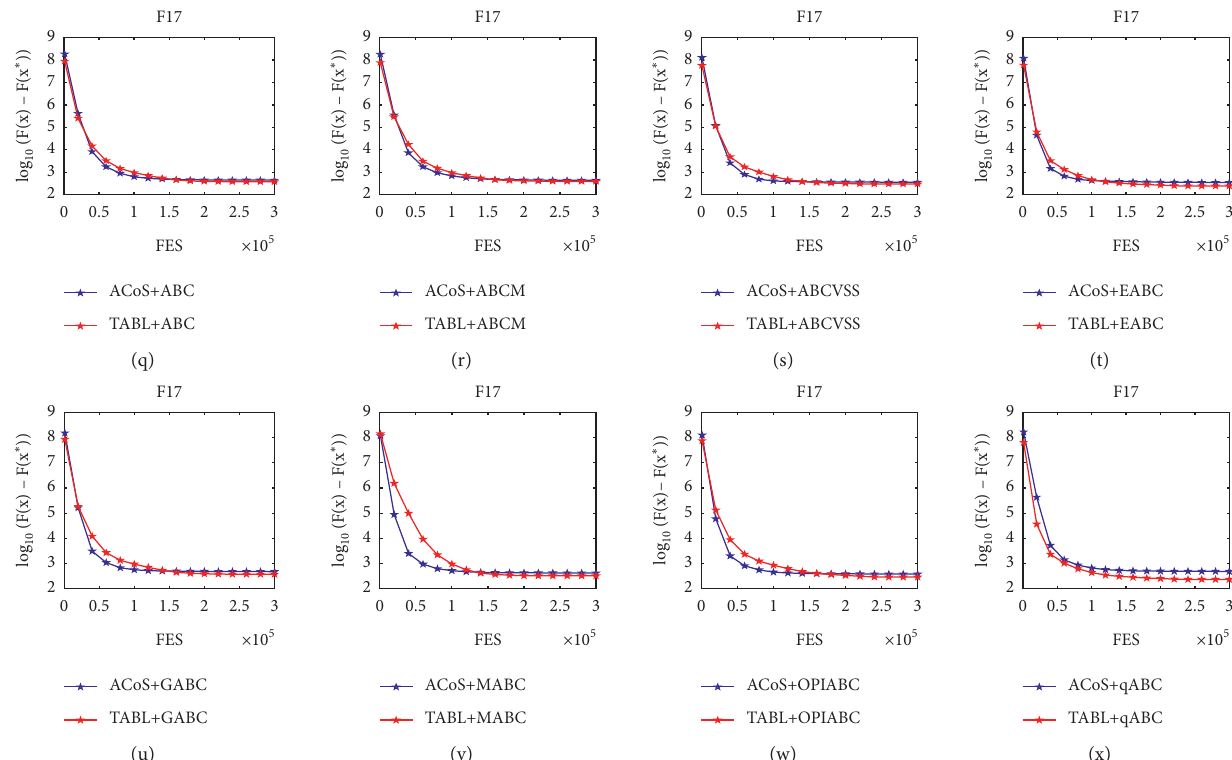
Figure 8: The mean function error values versus numbers of function evaluations for eight groups of ACoS+ ABCs vs. TABL+ABCs over 51 independent runs on F1, F7, and F17 with 30 D , respectively.